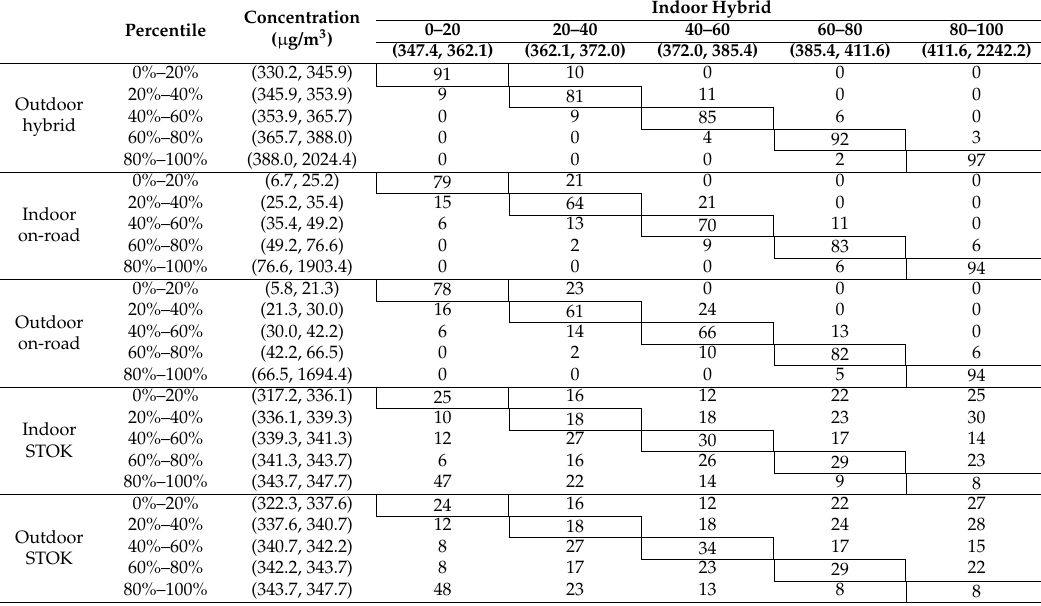
Table 3. Contingency table for CO showing agreement between exposure quintiles. The values represent percentage of Census blocks in each quintile. Concentration ranges are shown in parentheses. Boxed percentages along diagonals would be 100% for a perfect